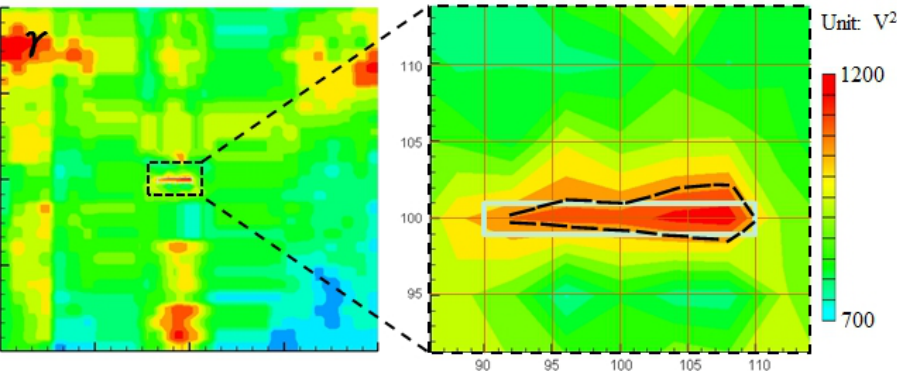
Figure 6. Experimental images of γ distribution for the aluminum plate with a non-penetrating slit (irradiated side without slit, result of PZT-(1 + 2 +